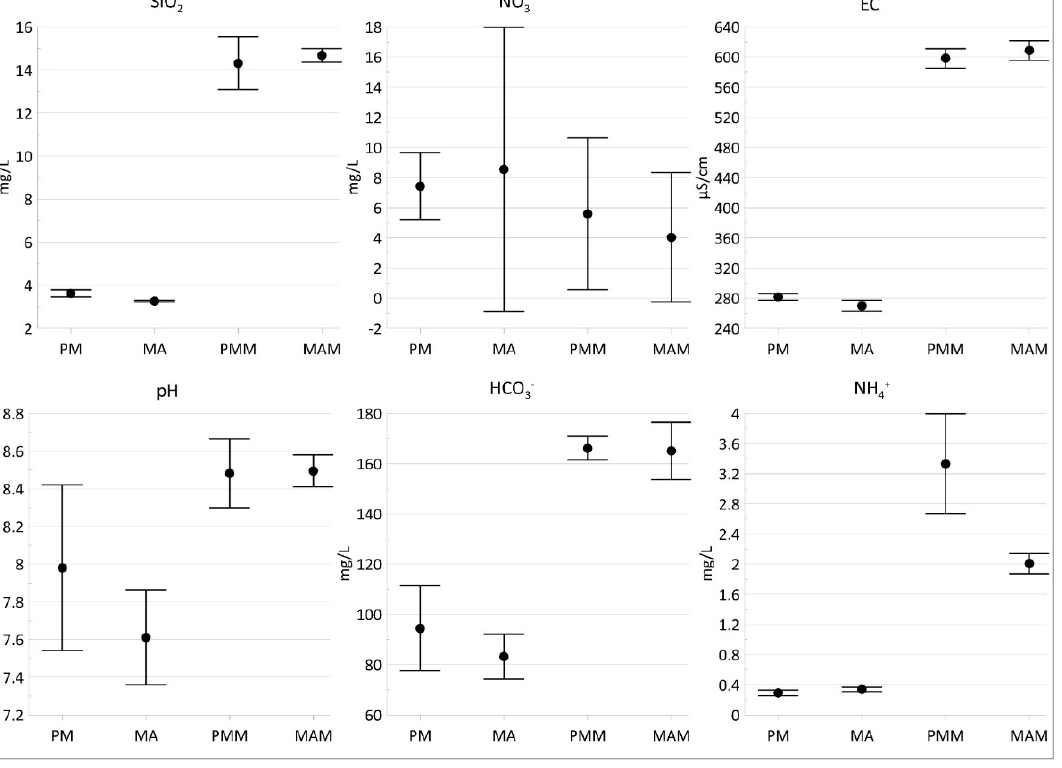
Figure 8. Physico-chemical parameters analyzed during the soil suspension tests. Means and standard deviations (n = 3) are presented.